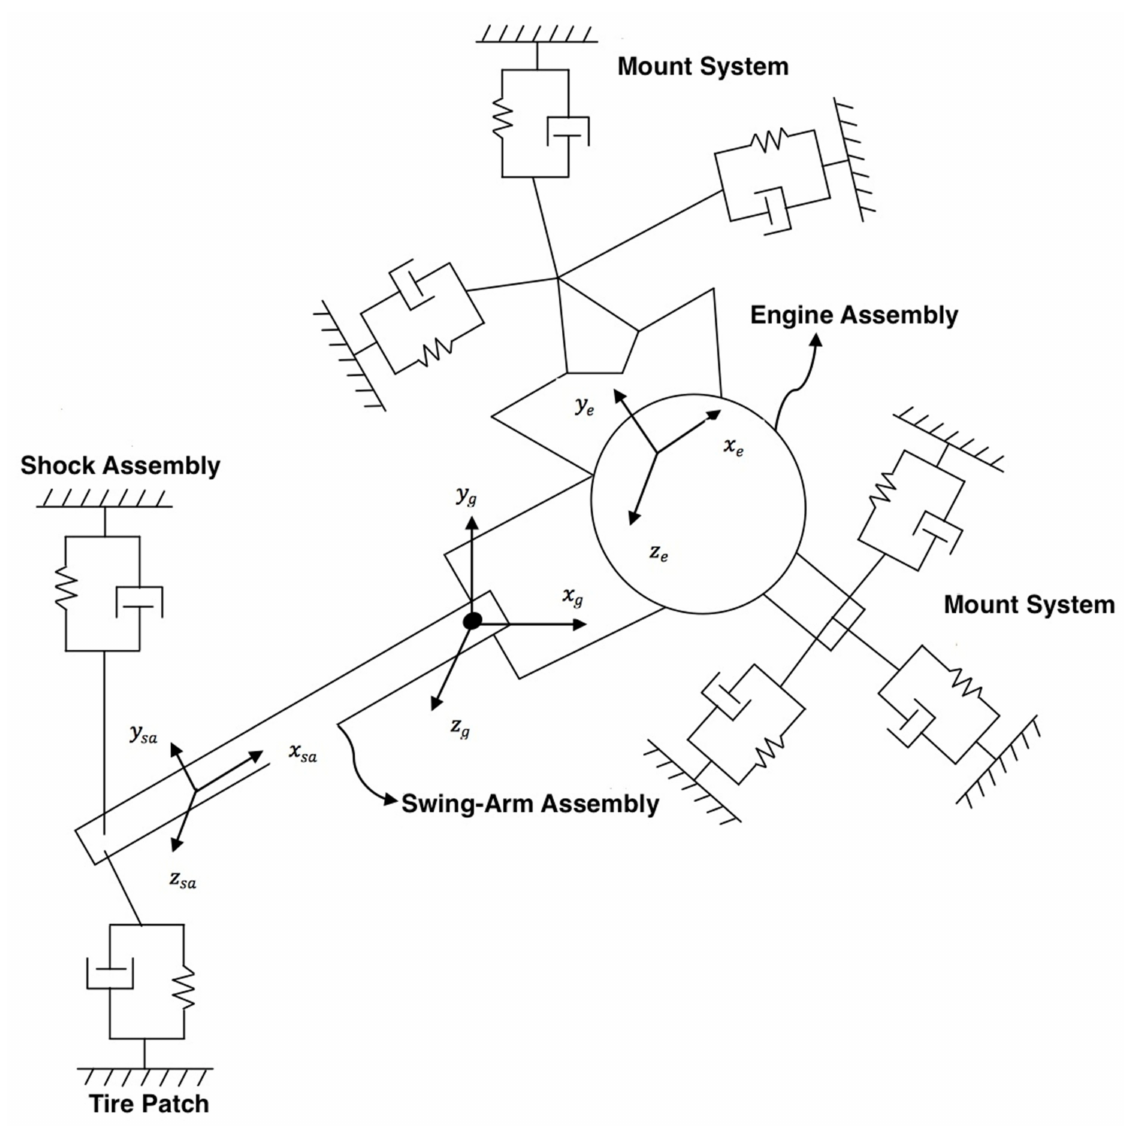
Figure 1. Powertrain and swing-arm layout